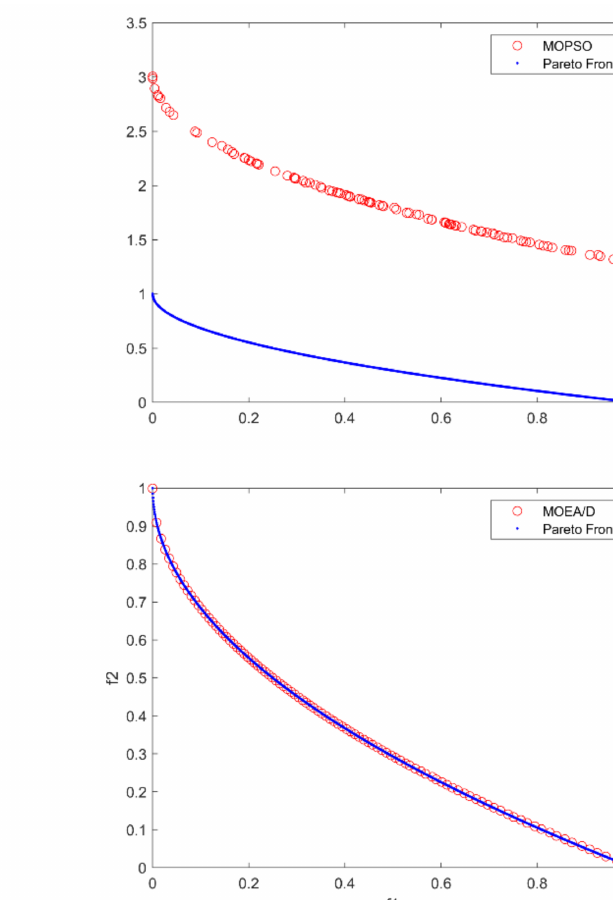
Figure 10. Comparison of the results of four algorithms for solving ZDT3 function.